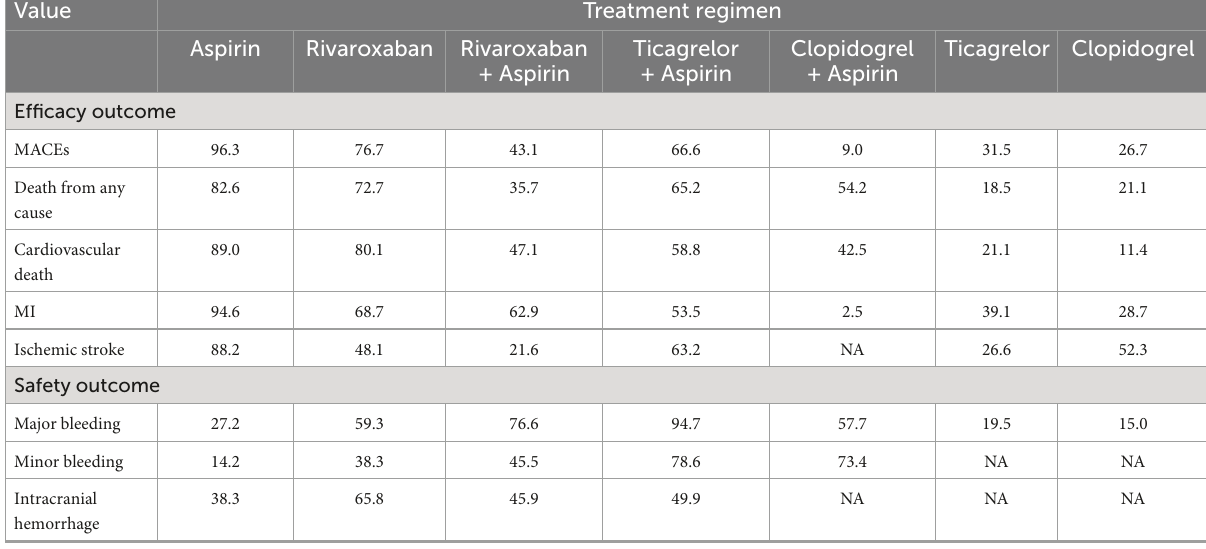
TABLE 1 SUCRA values* for each treatment regimen and